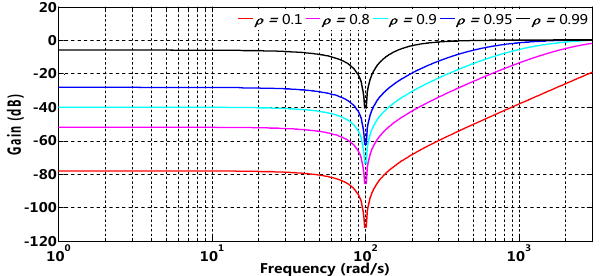
Figure 9. Magnitude gain of notch filter with respect to parameter ρ .